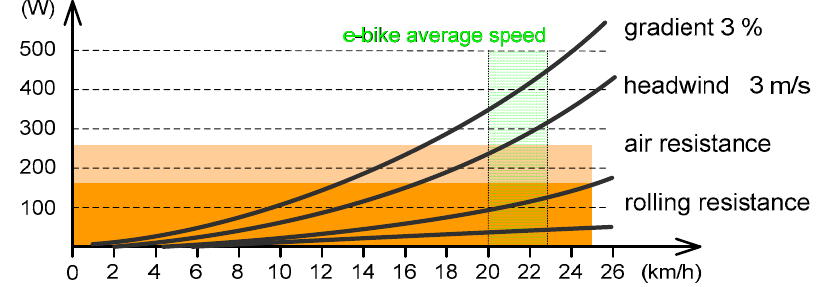
Figure 1. Power intervals required for cycling.